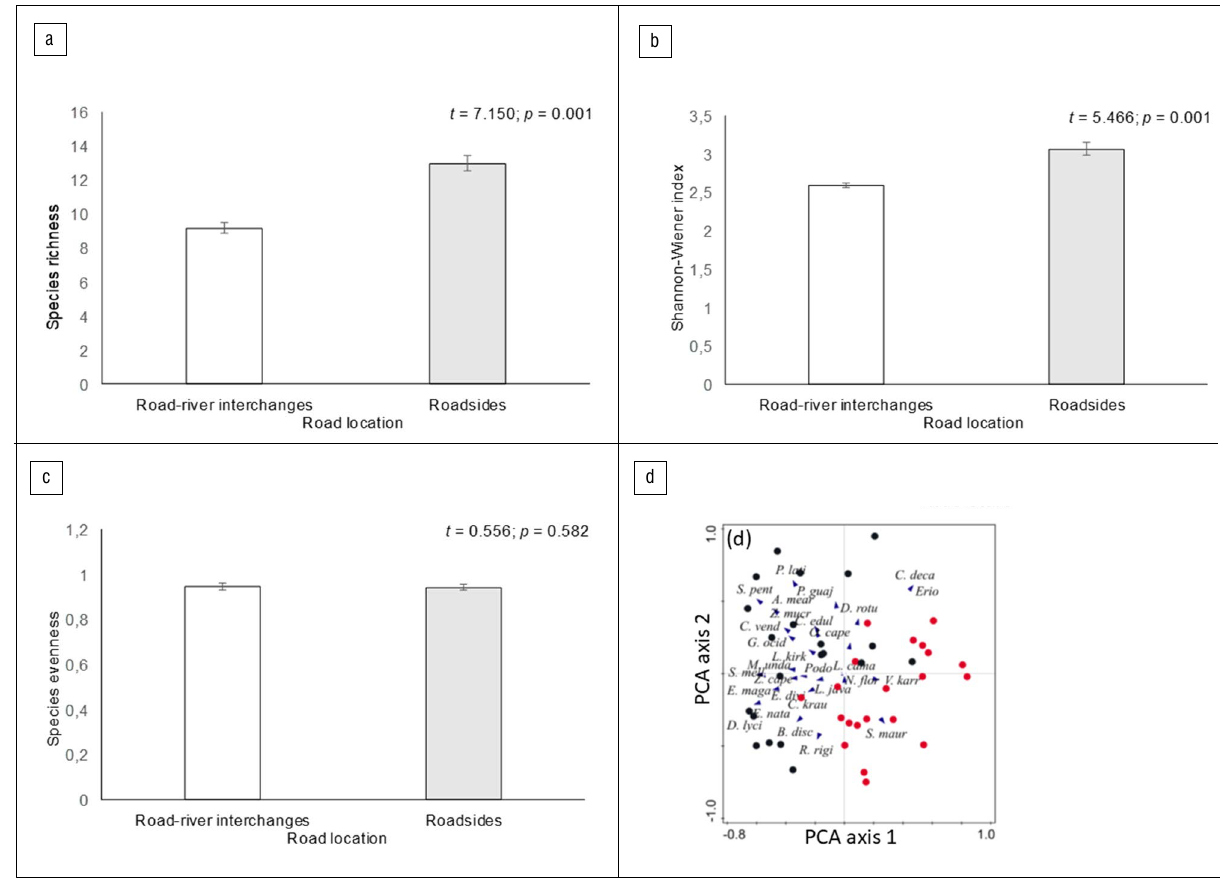
Figure 3: Comparison of (a) species richness, (b) Shannon–Wiener index and (c) evenness at different road locations. Data are means ± s.e. and t -test results are shown. (d) Principal component analysis (PCA) of species ( for identified trees and shrubs. The first four letters of the species names are presented, with full names given in Supplementary table